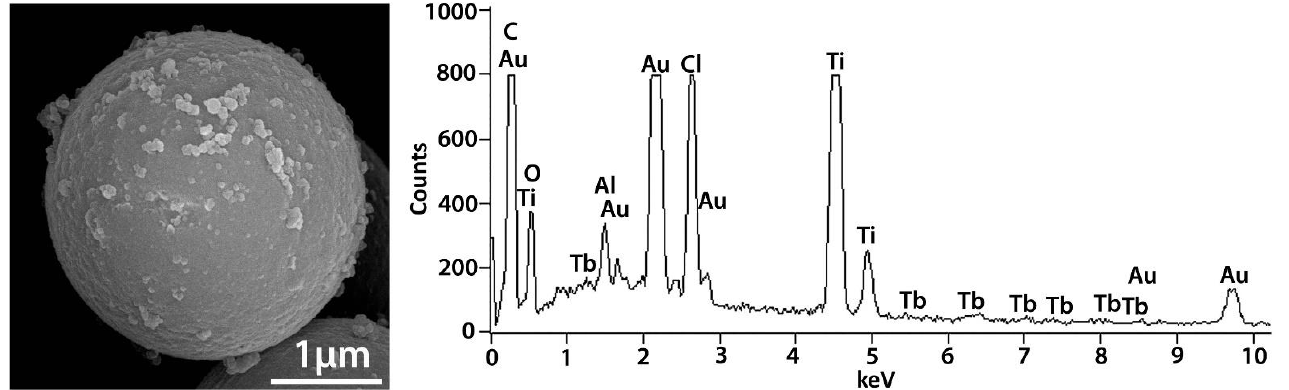
Figure 2. FEG-SEM picture of the mixture of the template + TiCl 4 and TbCl 3 precursors together with its characteristic XEDS analysis before the water addition, i.e., before hydrolysis and polycondensation reactions (HSs with 0.12 at.% Tb).